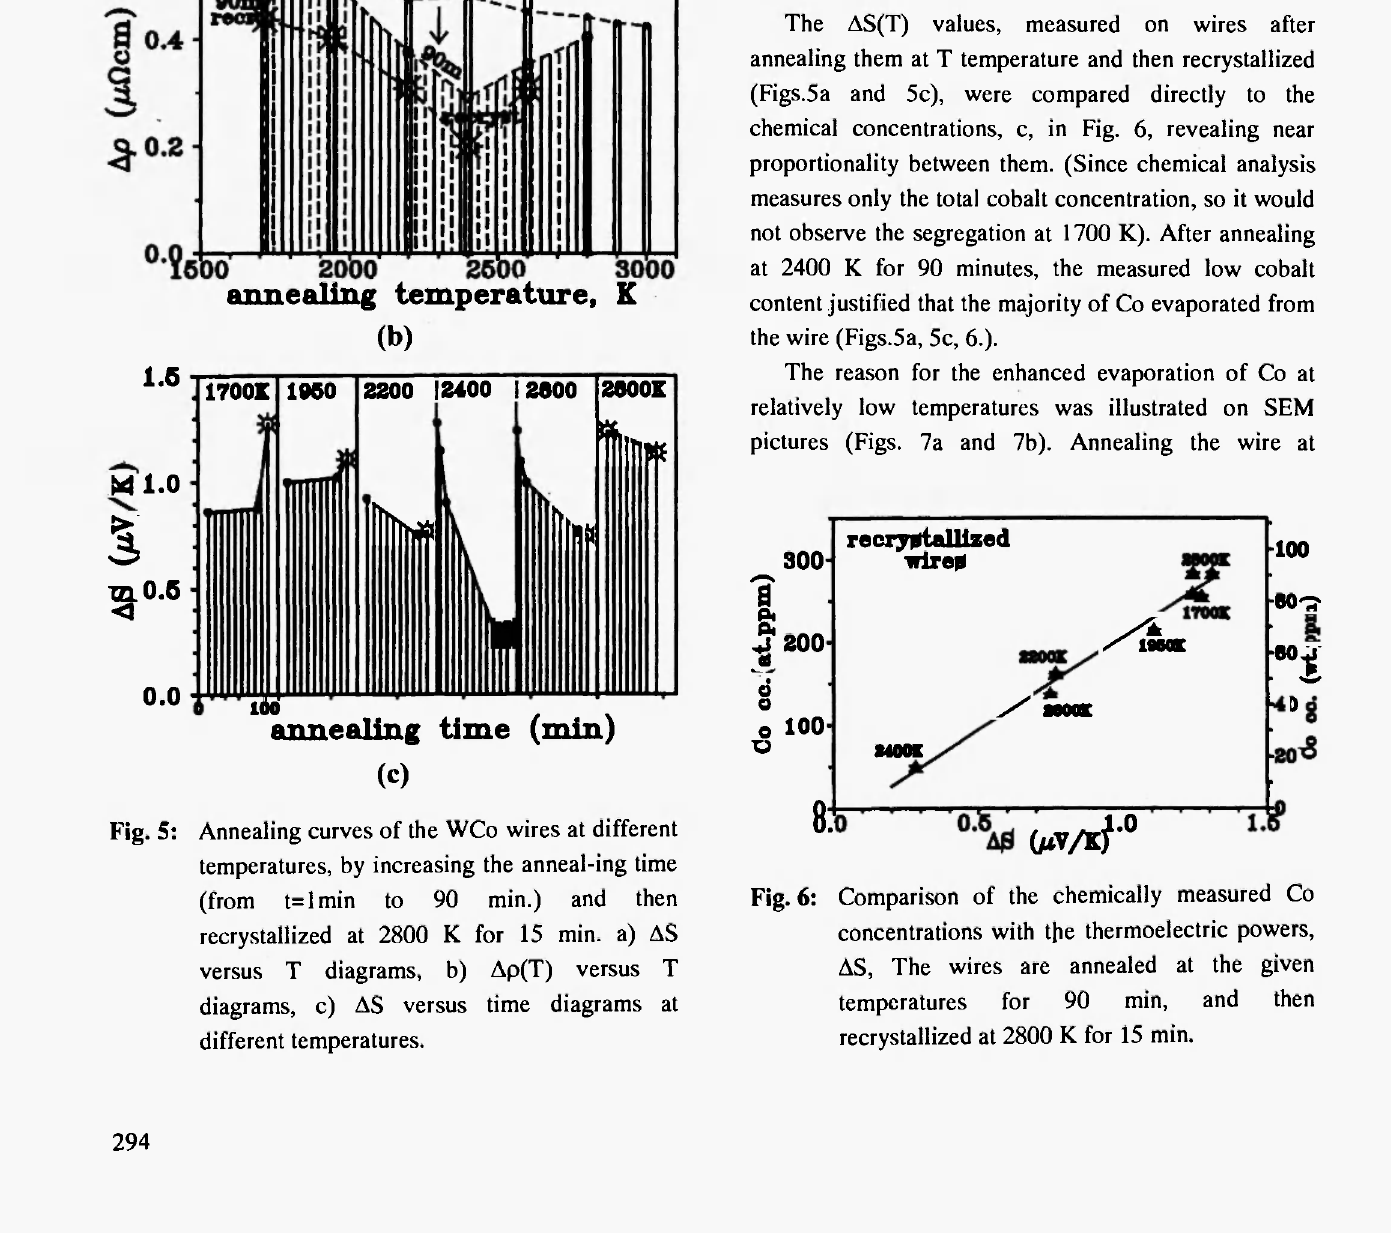
Fig. 5: Annealing curves of the WCo wires at different temperatures, by increasing the anneal-ing time (from t=lmin to 90 min.) and then recrystallized at 2800 Κ for 15 min. a) AS versus Τ diagrams, b) Δρ(Τ) versus Τ diagrams, c) AS versus time diagrams at different temperatures.